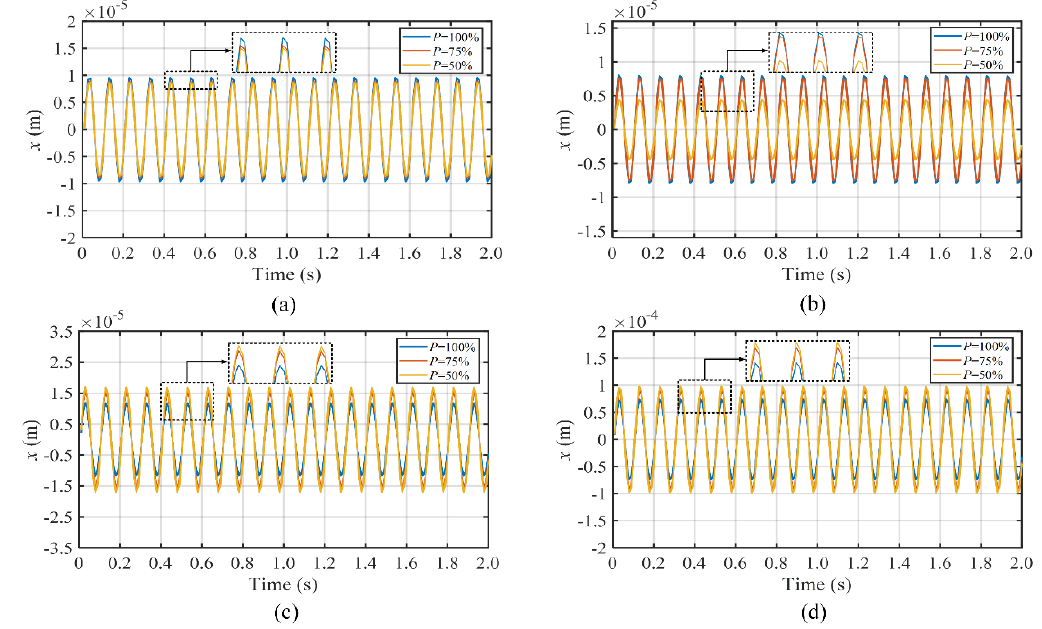
Figure 8. Vibration characteristics of different guide bearings and the flange. ( a ) The upper guide bearing; ( b ) the lower guide bearing; ( c ) the flange; ( d ) the water guide